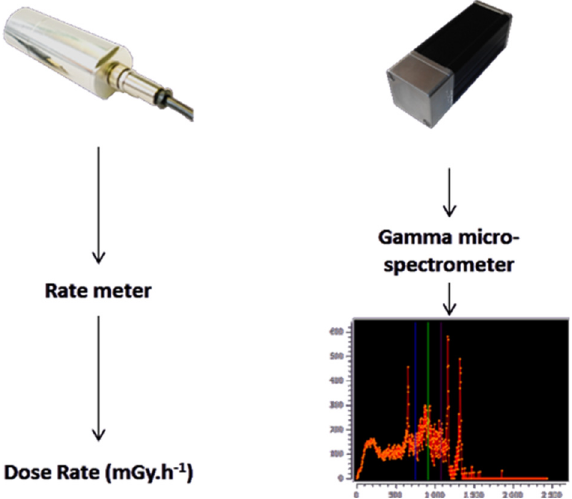
Fig. 2. Outcoming data from nuclear measurements